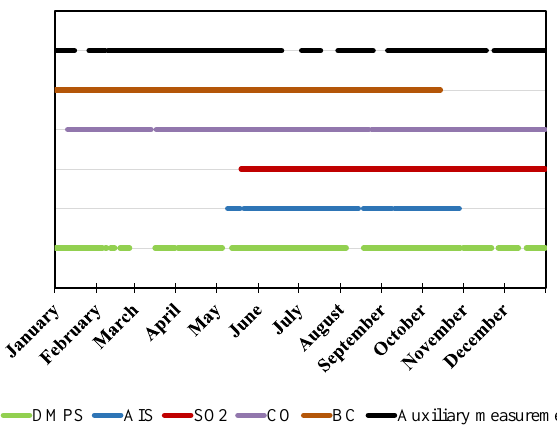
Figure 2. Data set from the 2015 Maïdo campaign. Devices recorded data simultaneously from May to November.